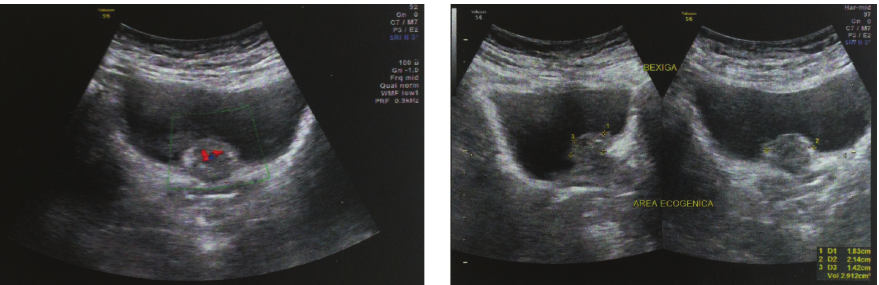
Figure 1: Ultrasound showing a 21mm vegetating lesion on the bladder neck.